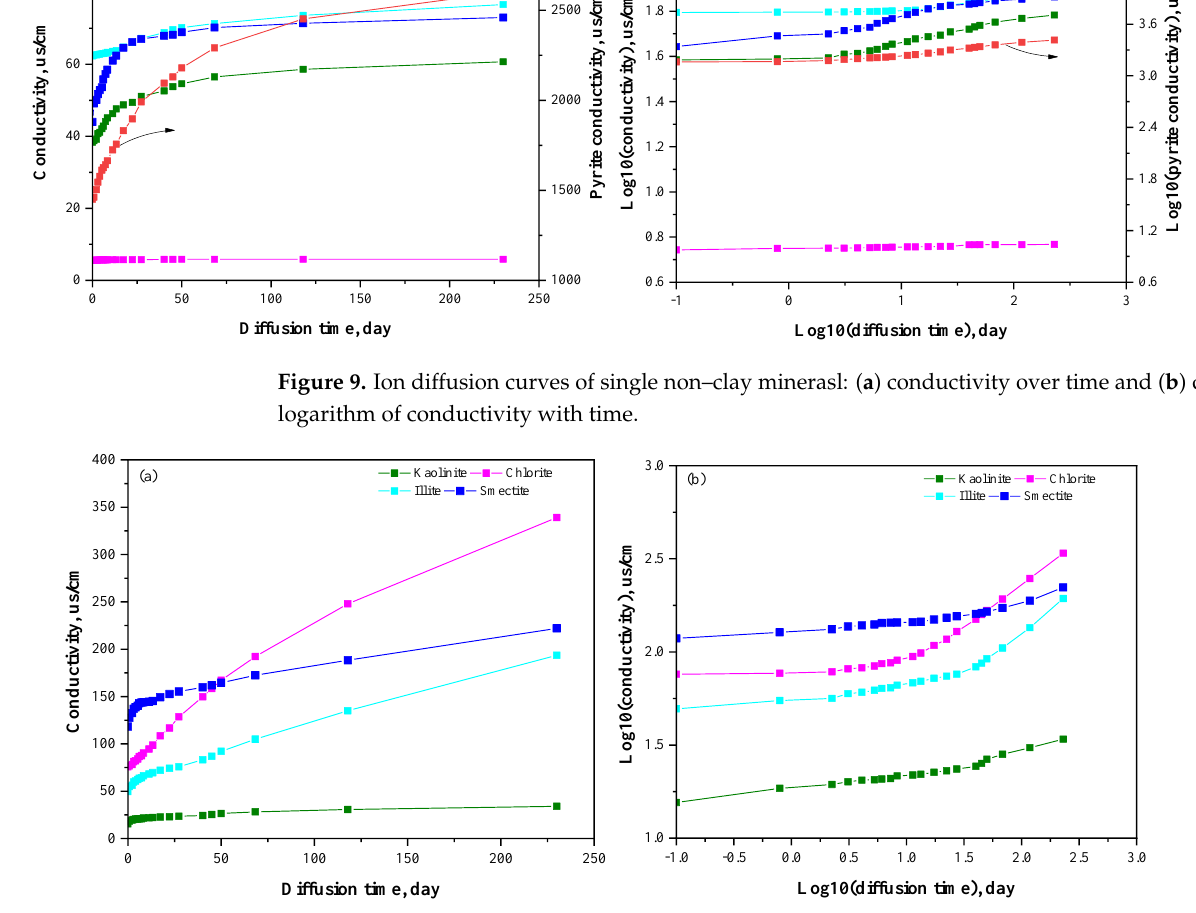
Figure 10. Ion diffusion curves of single clay minerals: ( a ) conductivity over time and ( b ) double logarithm of conductivity with time. Table 5. Salinity analysis of immersion solution for tight sandstone particles. Non – Clay Mineral